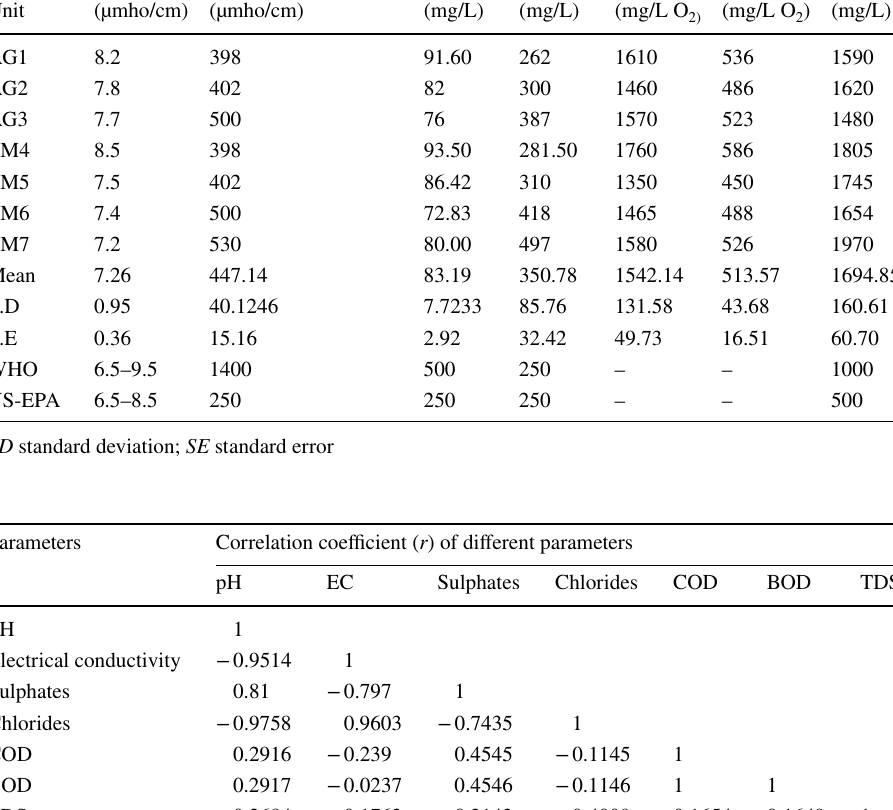
properties of collected industrial effluent samples